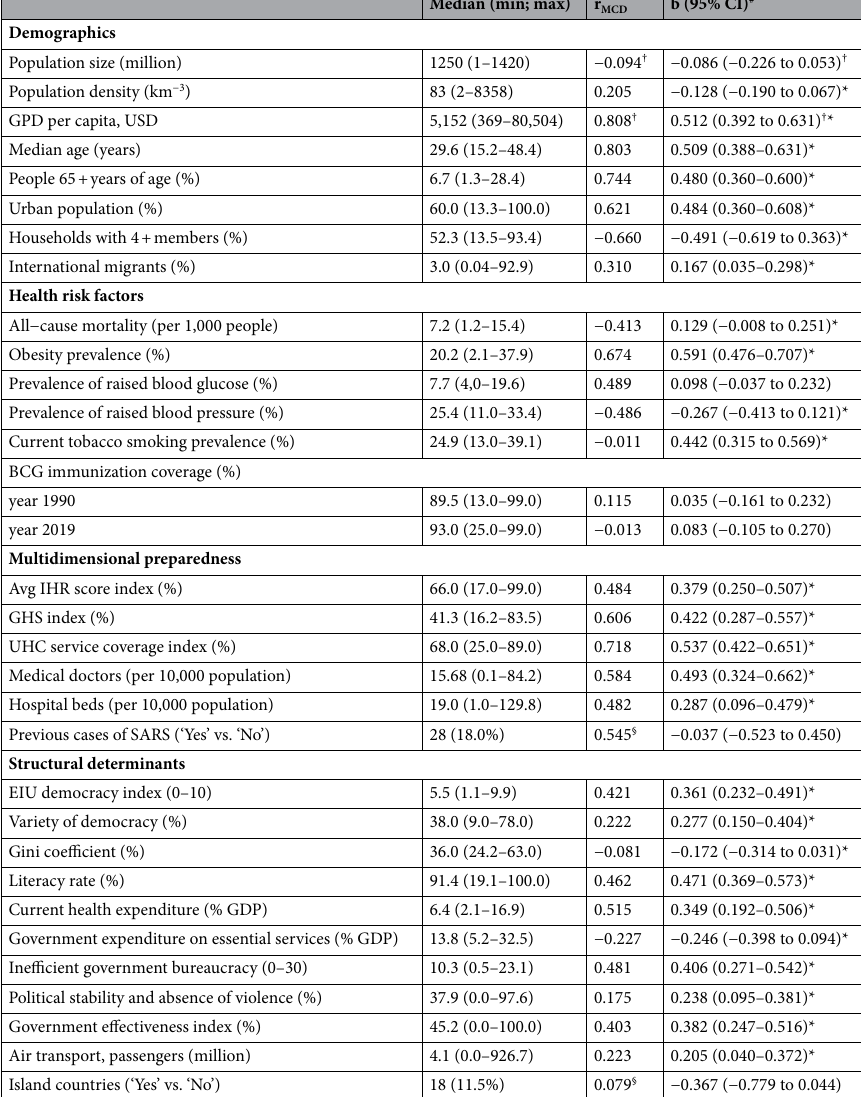
Table 1. Demographics, health risk factors, preparedness and response indicators, structural economical- political determinants. Robust correlation coefficient (r MCD ) based on the Minimum Covariance Determinant estimator was computed to estimate the strength of the association between the covariate and the log of COVID-19 deaths per million. * Significant p-values for b coefficients with robust standard errors of the simple OLS regression models against COVID-19 deaths per million (logged). # Covariates were standardized before computing OLS regression coefficients. † Log-transformed to normalize the distribution frequency. § Not significant student t-value calculated to compare log of COVID-19 mortality between countries with and without previous SARS cases. BCG Bacillus Calmette-Guerin; COVID-19 coronavirus disease 2019; EIU Economist intelligence unit; GDP gross domestic product; GHS Global Health